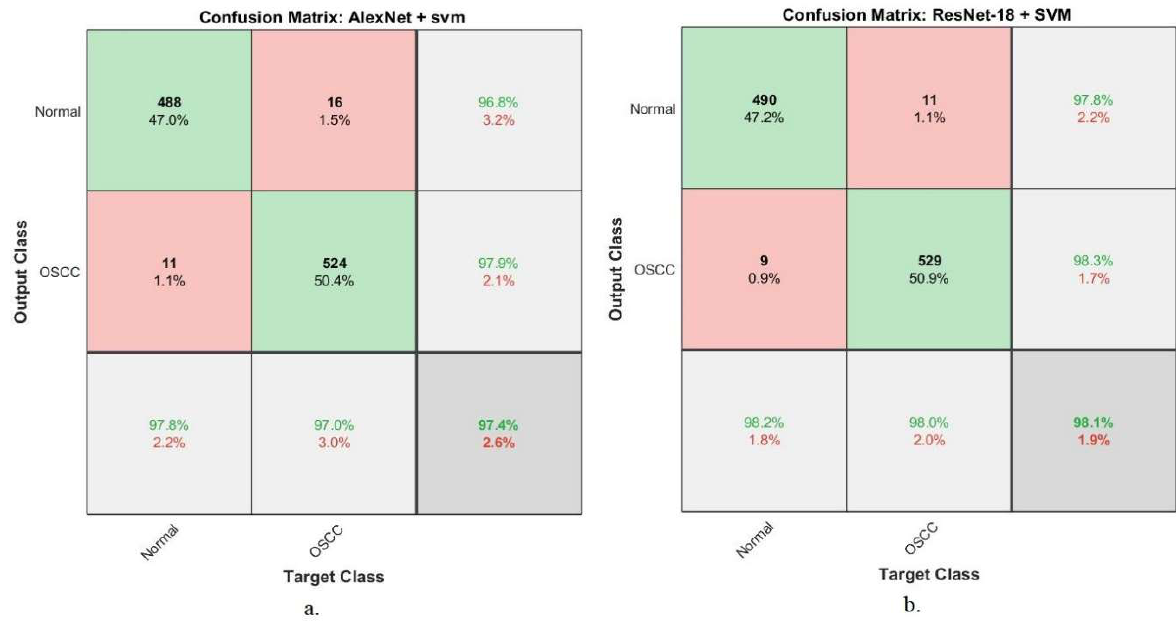
Figure 7. Confusion matrix for performing hybrid techniques for OSCC data set diagnostics. ( a ) AlexNet + SVM; ( b ) ResNet-18 +